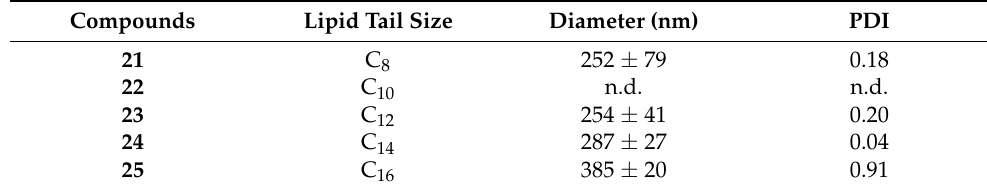
Table 2. Mannosylated neoglycolipid self-assembly analysis by DLS. Compounds Lipid Tail Size